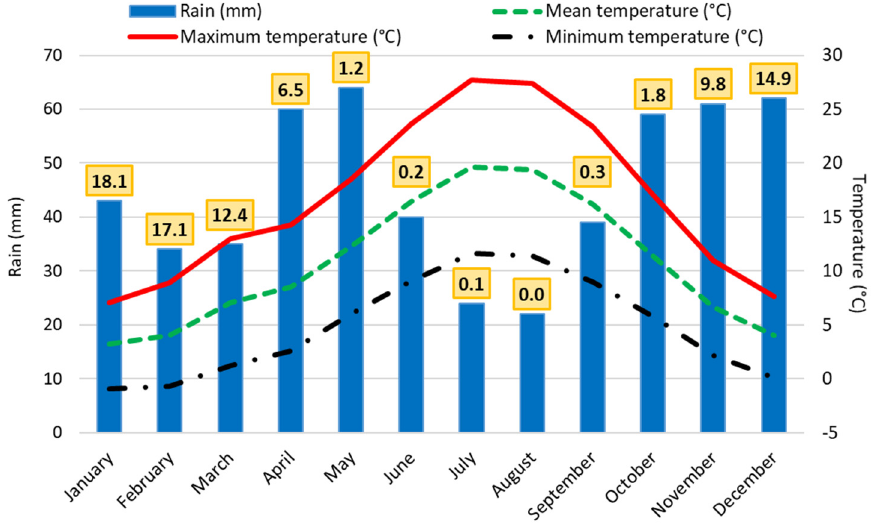
Figure 8. Climatology of Burgos, Spain (adapted from [40]). Frosty days in yellow rectangles.